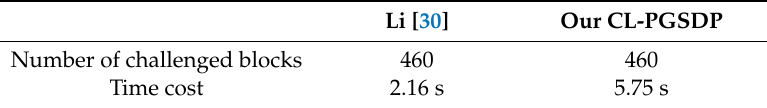
Figure 4. Increasing number of challenges for fixed size of data. Table 2. Comparison of Proof-Check with Li